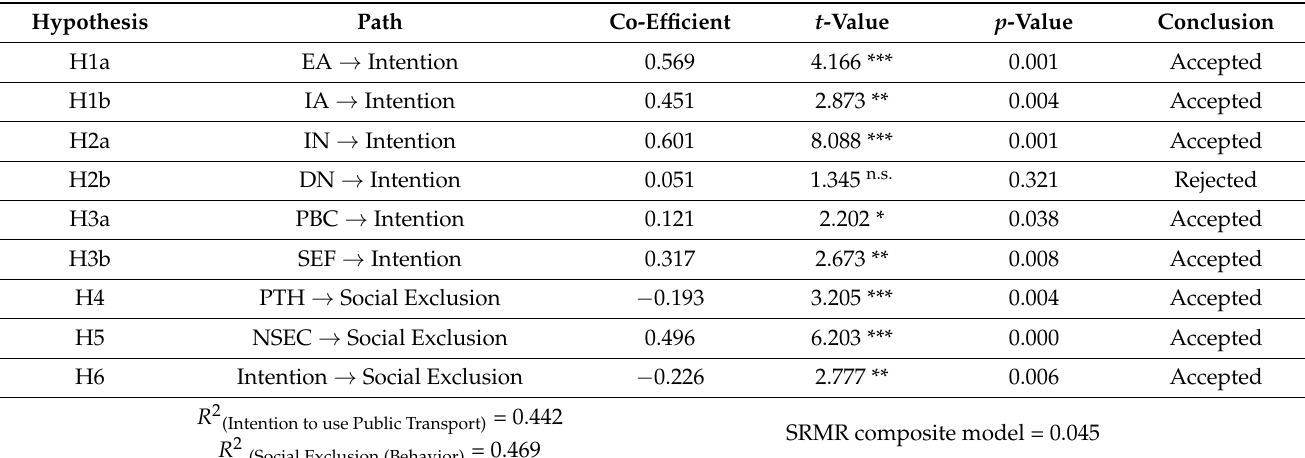
Table 3. Summary of the result of